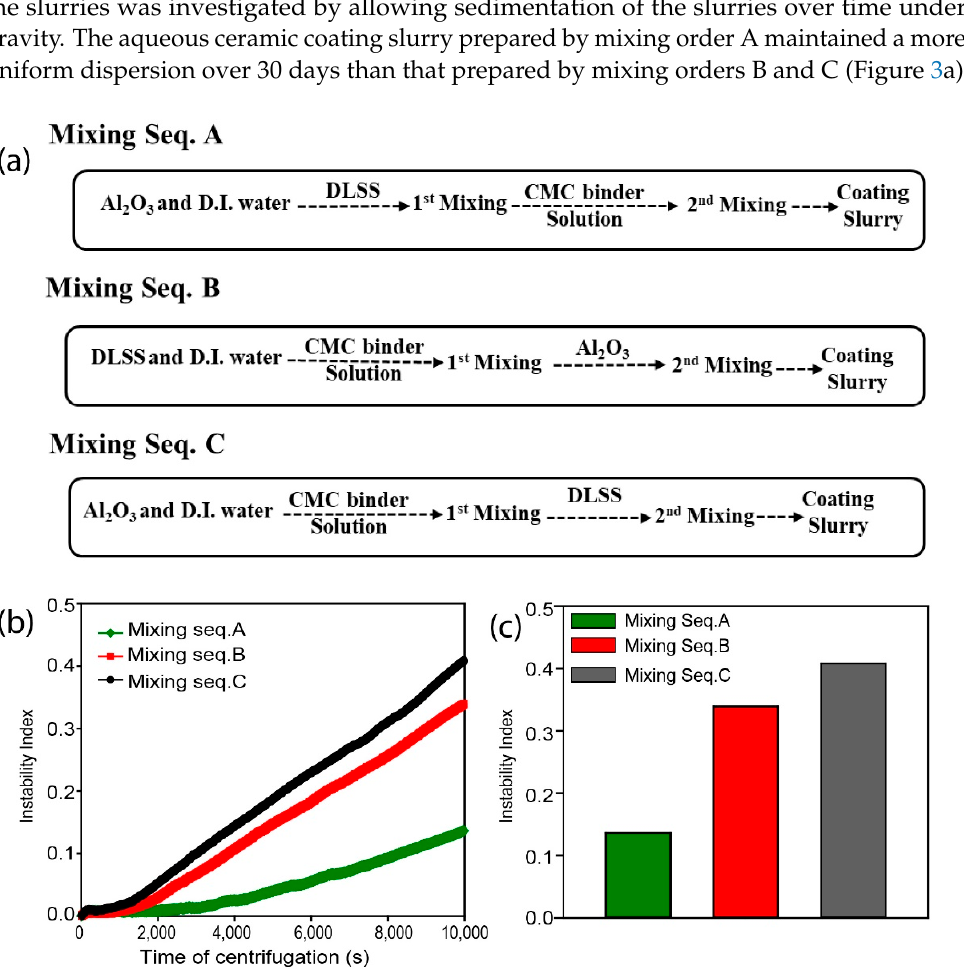
Figure 2. ( a ) Schematic illustration of the different ceramic slurry preparations according to three mixing sequences. ( b , c ) Variation of instability index of Al 2 O 3 ceramic slurries containing 0.1 wt.% DLSS and comparison of instability index of slurries according to the three mixing sequences respectively.